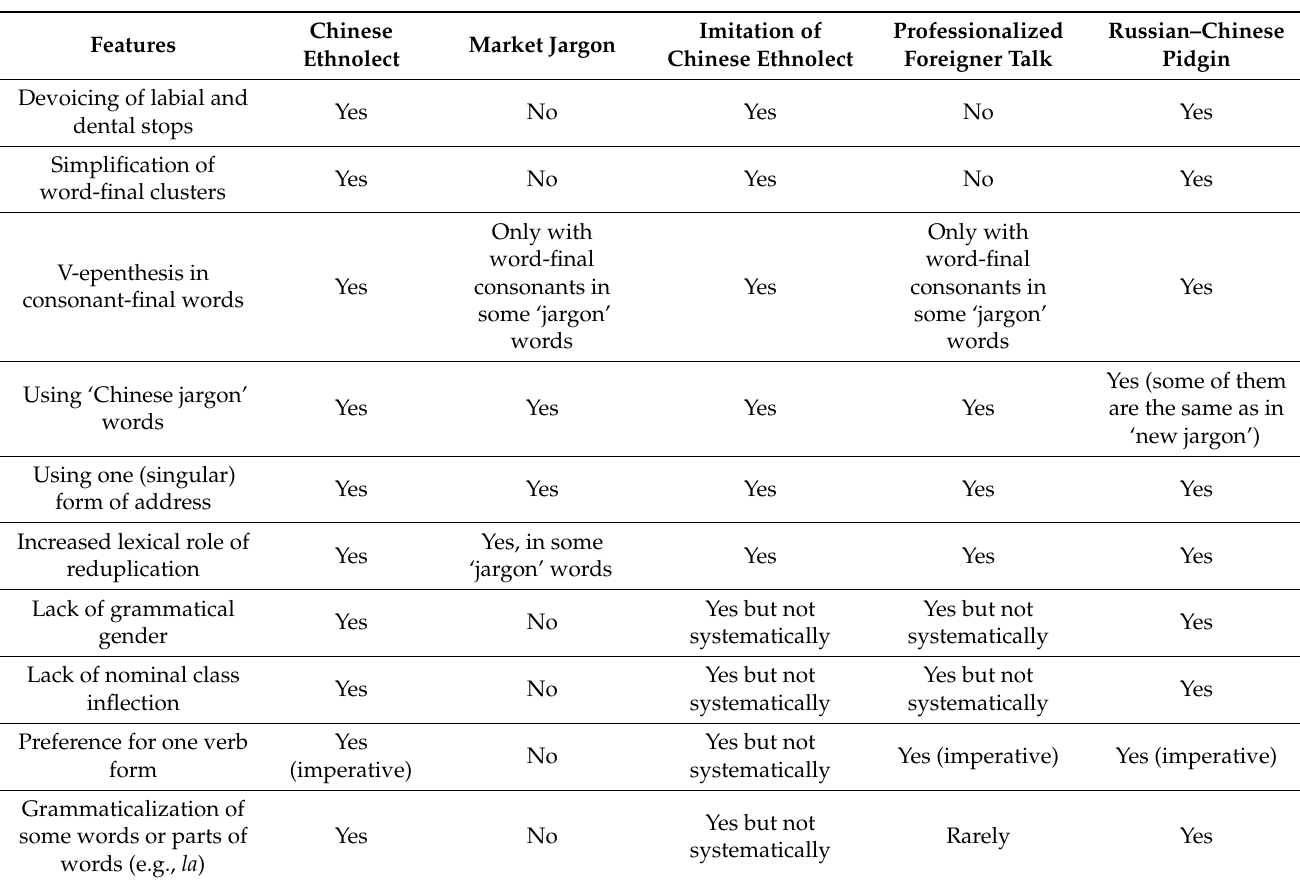
Table 1. Comparison between speech